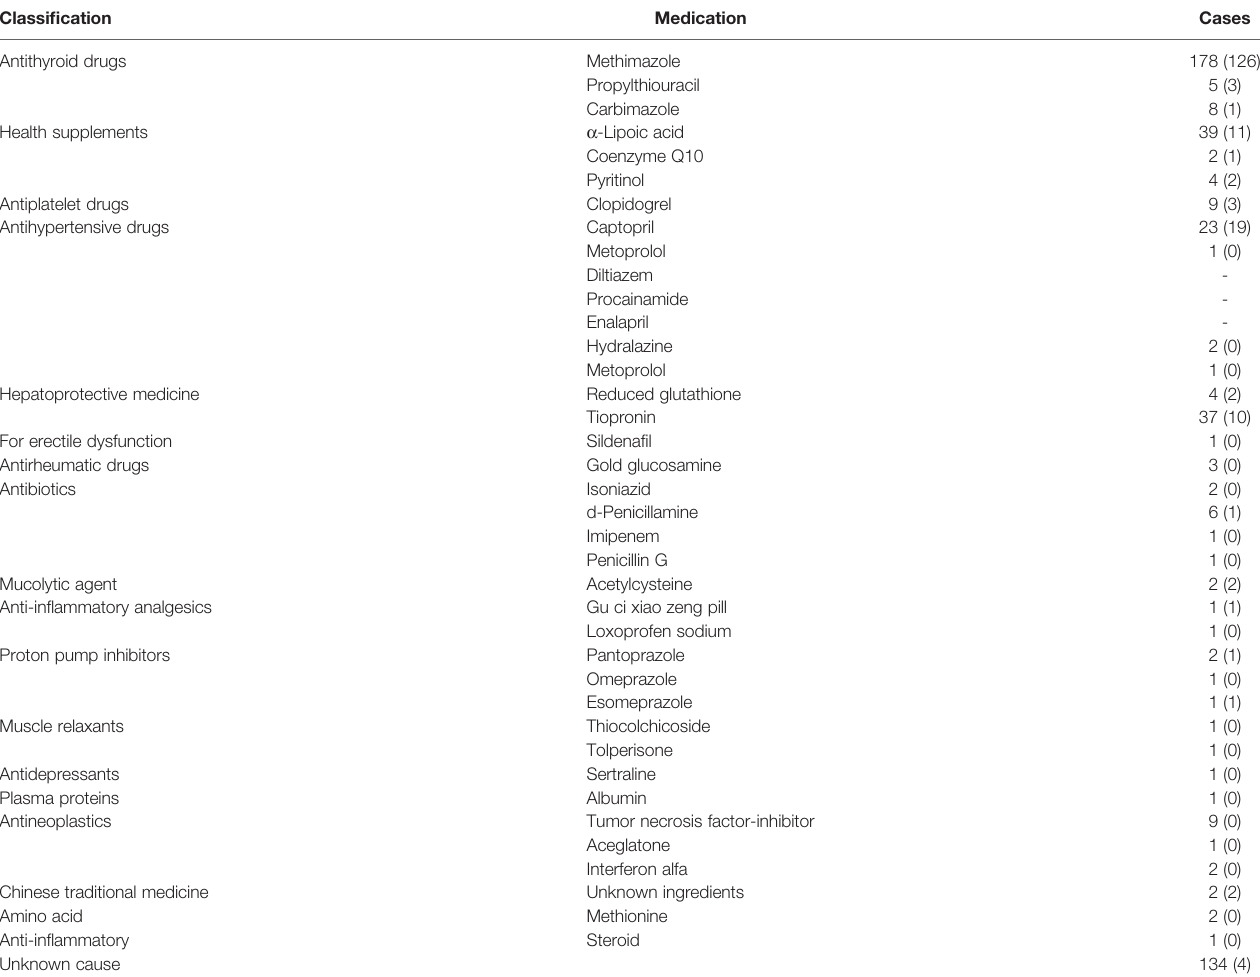
TABLE 2 | Classes of medications related to AIH and number of cases